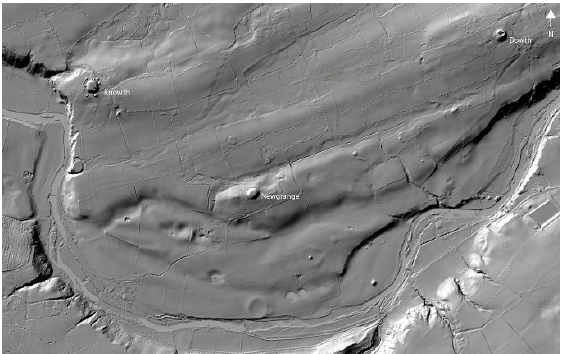
Figure 3. The results of an aerial LiDAR survey of the Boyne Valley, showing the three ‘mega mounds’ of Brú